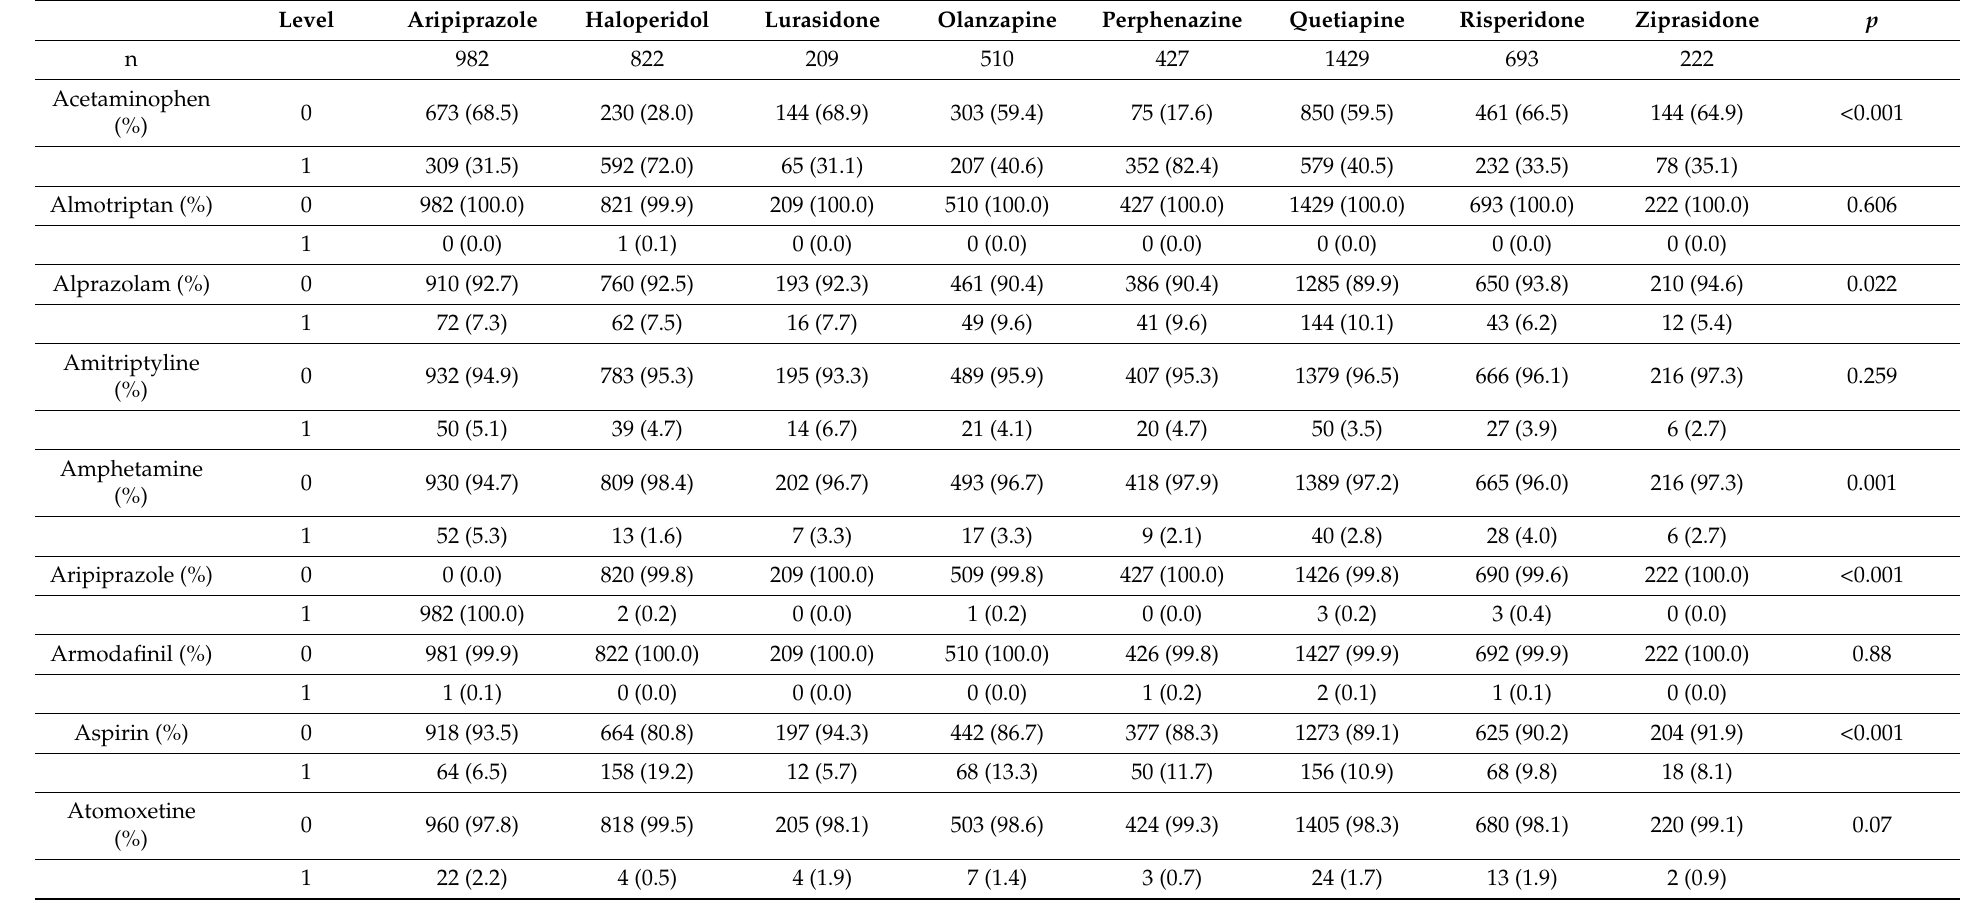
Table A2. Information of Concomitant Medications Targeting on Central Nervous